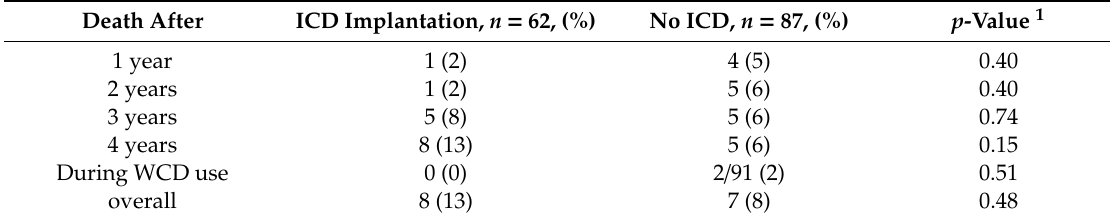
Table 4. 4-year mortality by ICD implantation during median follow-up (median 34: IQR 24–46 months). Death After